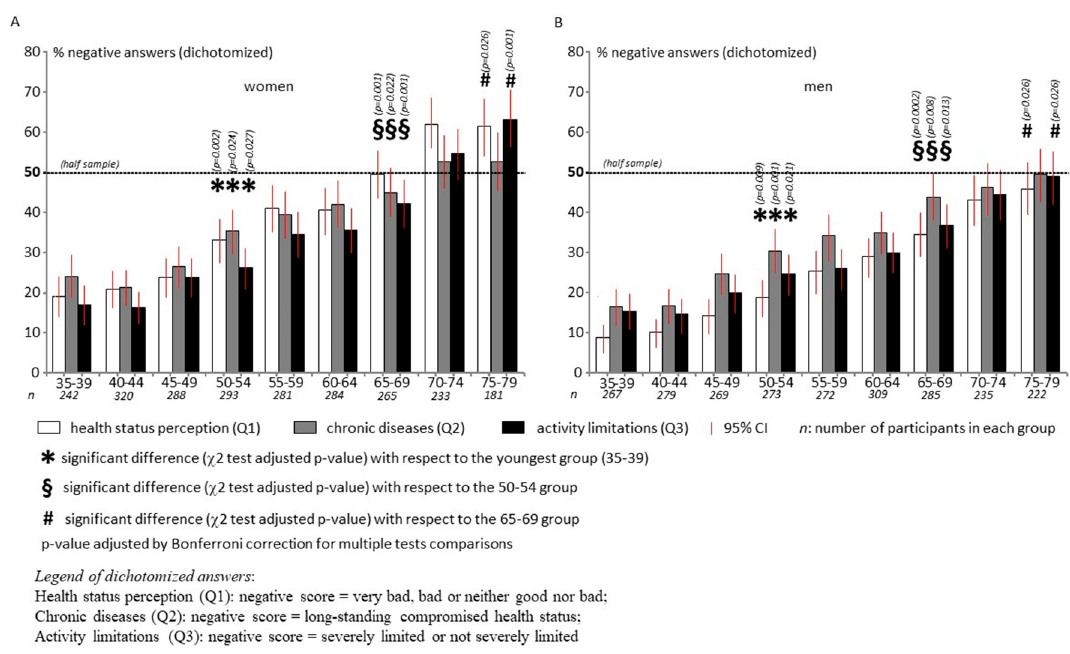
Figure 1. Prevalence and 95% confidence intervals (CIs) of negative answers to the dichotomized the Minimum European Health Module (MEHM) items, plotted for women ( A ) and for men ( B ) (data source: the CUORE Project Health Examination Survey 2008–2012, Italian men and women, 35–79 years old).